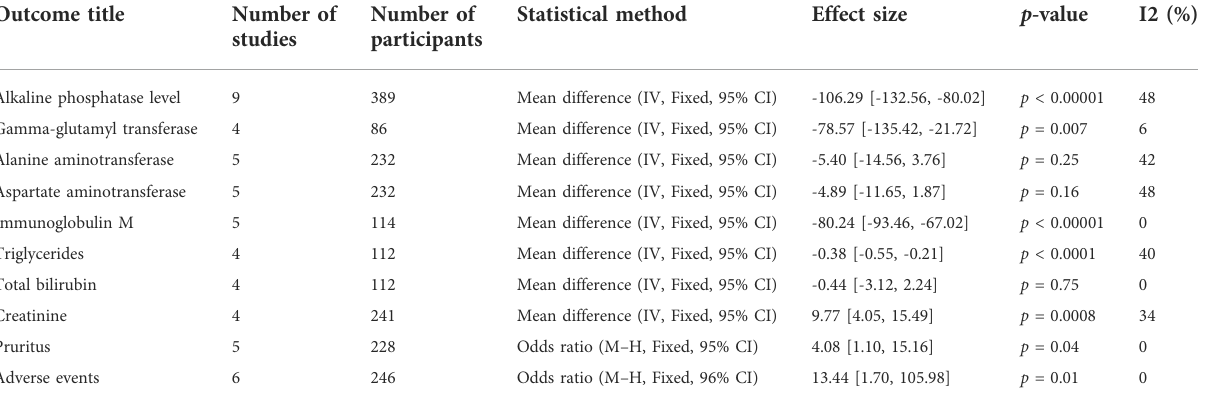
TABLE 2 Meta-analysis of clinical events and biochemical parameter changes in the included